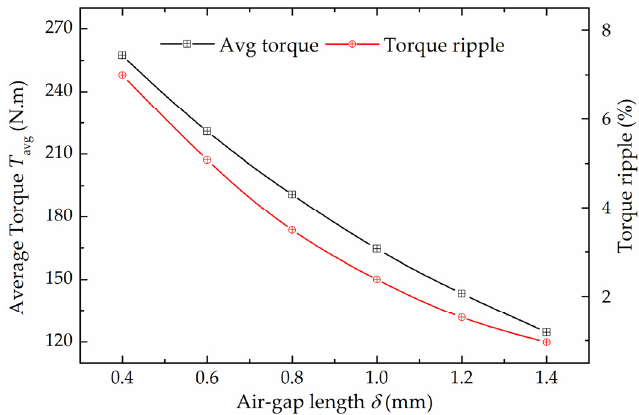
Figure 13. The influence of air ‐ gap length δ on average torque and torque ripple.